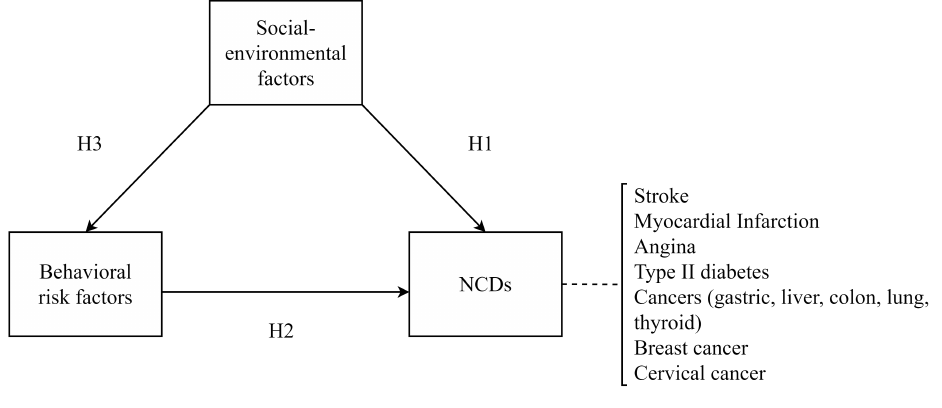
Figure 1. The research